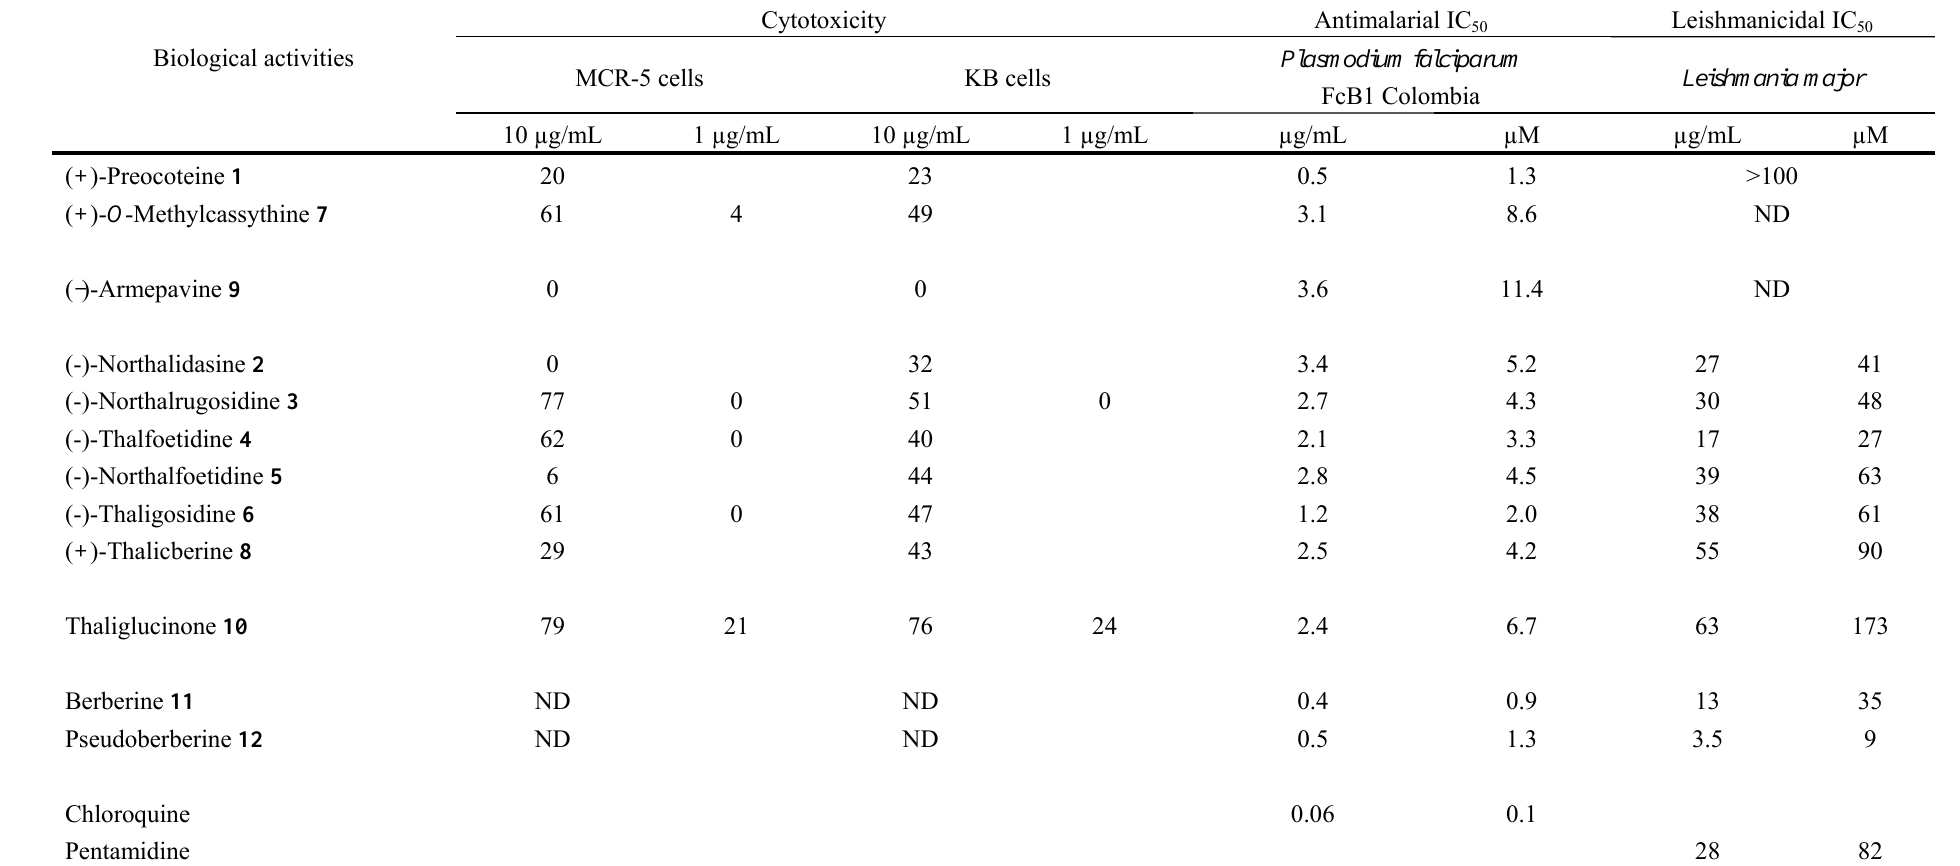
Table 1. In vitro cytotoxicities and antiparasitic activities of compounds 1 - 12